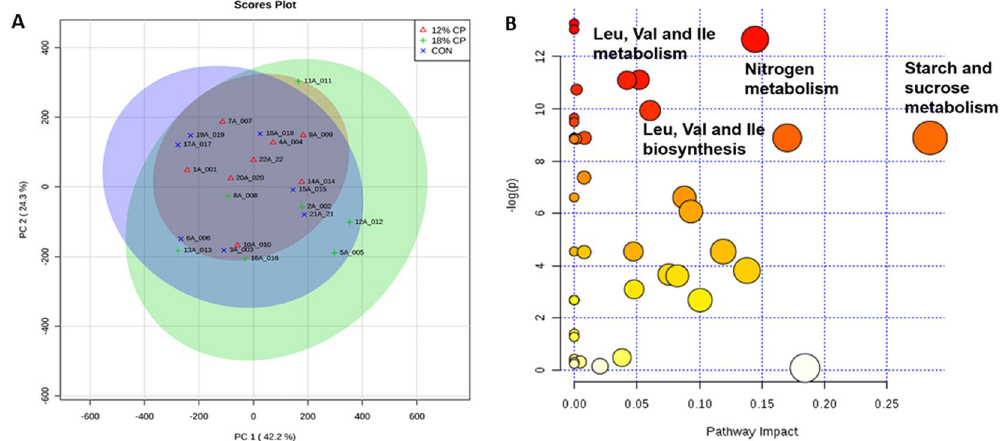
Figure 2. Principle component analysis (PCA) score plots and the pathway analysis map of serum metabolites in piglets fed with low protein diets. ( A ) PCA score plots of serum metabolites. Each node represents an individual pig. ( B ) The map of pathway analysis for the metabolites detected in the blood serum. Each circle represents a metabolic pathway with the scores obtained from topology analysis (pathway impact; the x-axis) and the pathway enrichment analysis (y-axis). The color of each circle is based on its p -value, while the size of each circle is based on its impact values. Therefore, larger size circles are indicative of higher pathway impact, while darker colors circles are suggestive of more significant changes of metabolites and higher pathway enrichment. No difference in pathway enrichment was found between CON and 18% crude protein (CP) or between 18% CP and 12% CP. Therefore, the data for both CON and 18% CP were combined and compared with 12% CP for pathway enrichment. CON, control diet with 24% CP; 18% CP, low protein diet with 18% CP; 12% CP, low protein diet with 12% CP. n = 7, n = 7, n = 8 for CON, 18% CP and 12% CP groups,